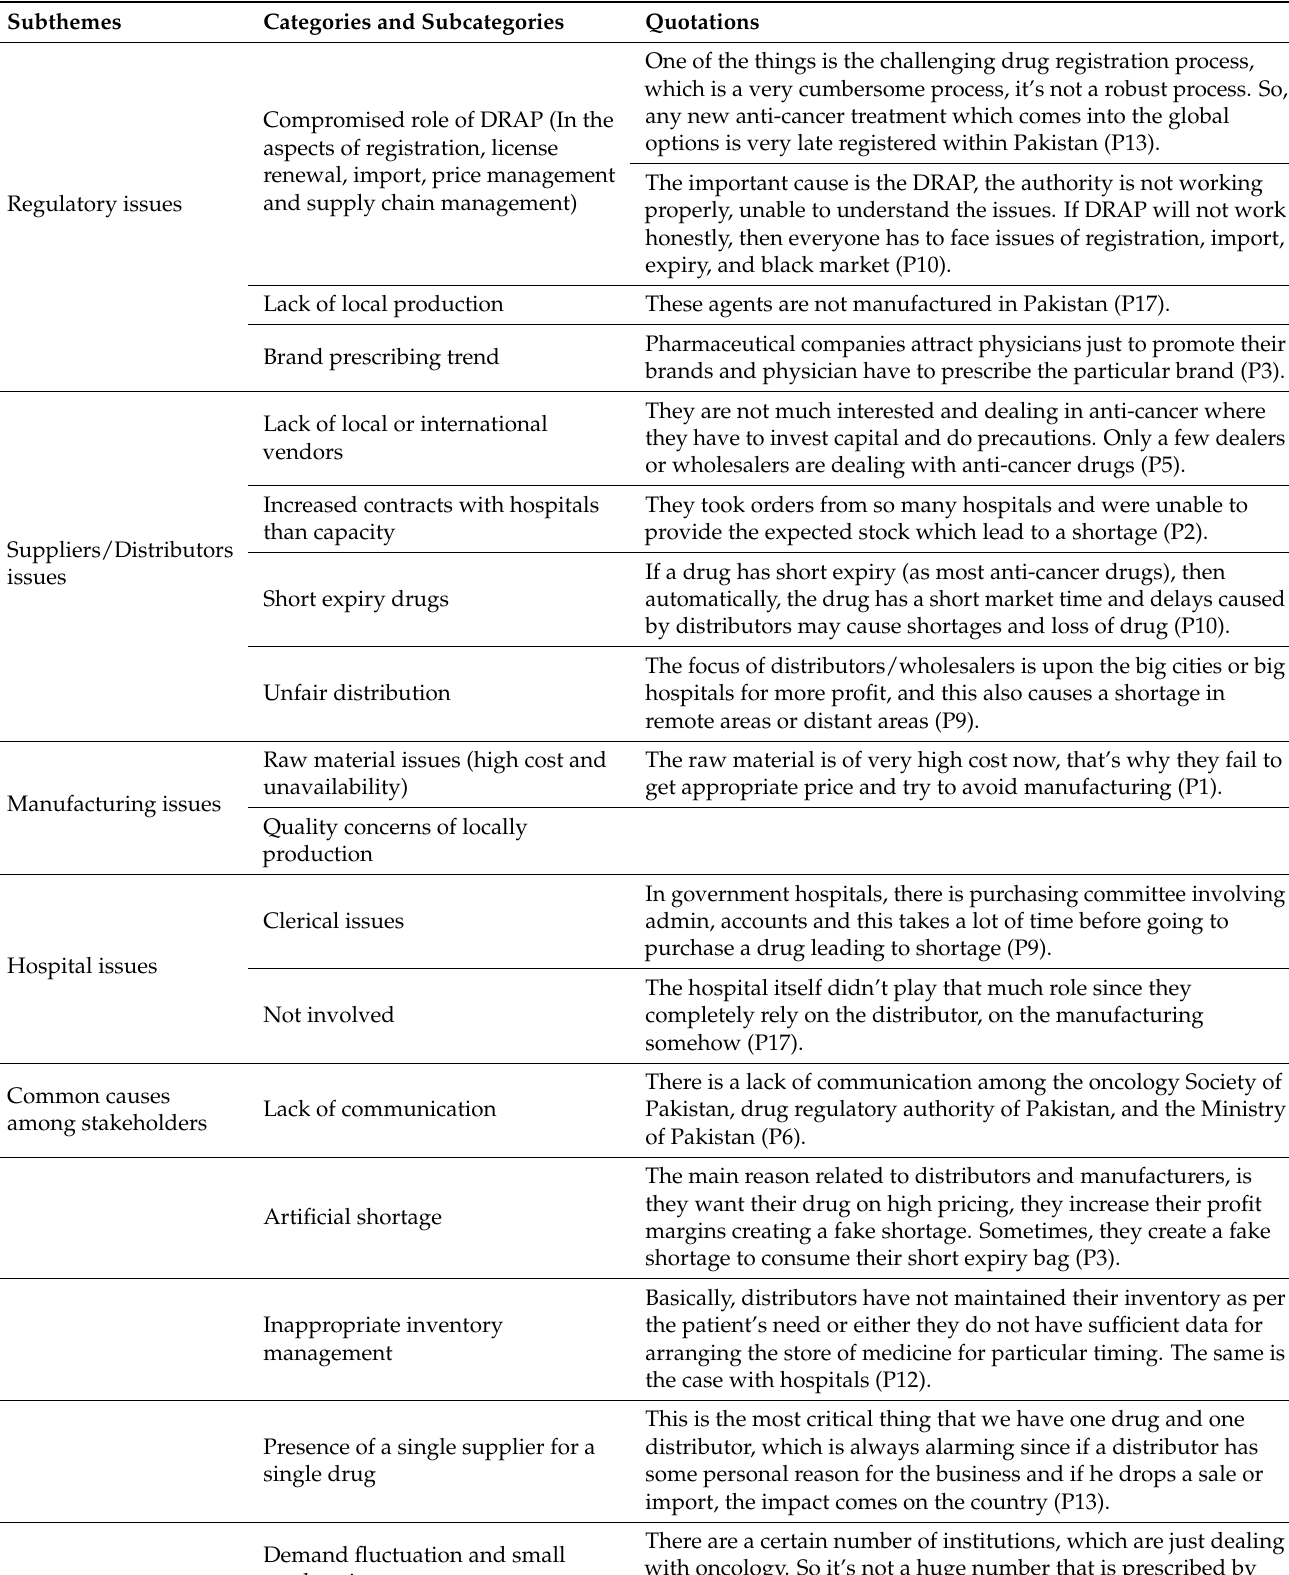
Table 3. Theme 2: Determinants of anti-cancer medicines